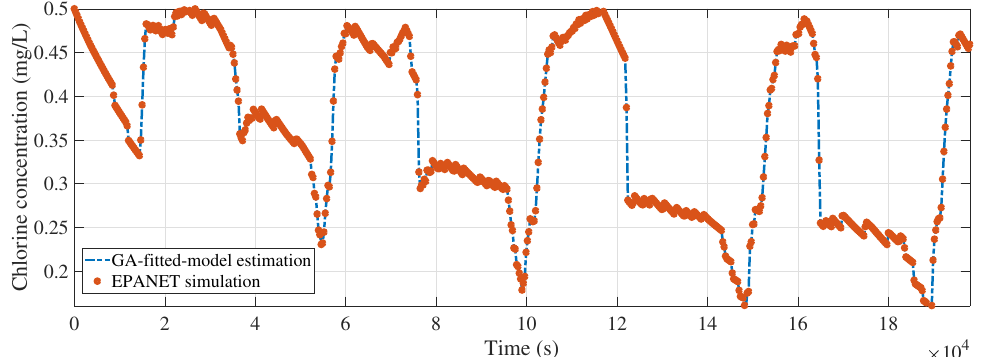
Figure 9. Calibrated model fitting for node 20 (rmse = 1.0999 × 10 − 4 mg/L).